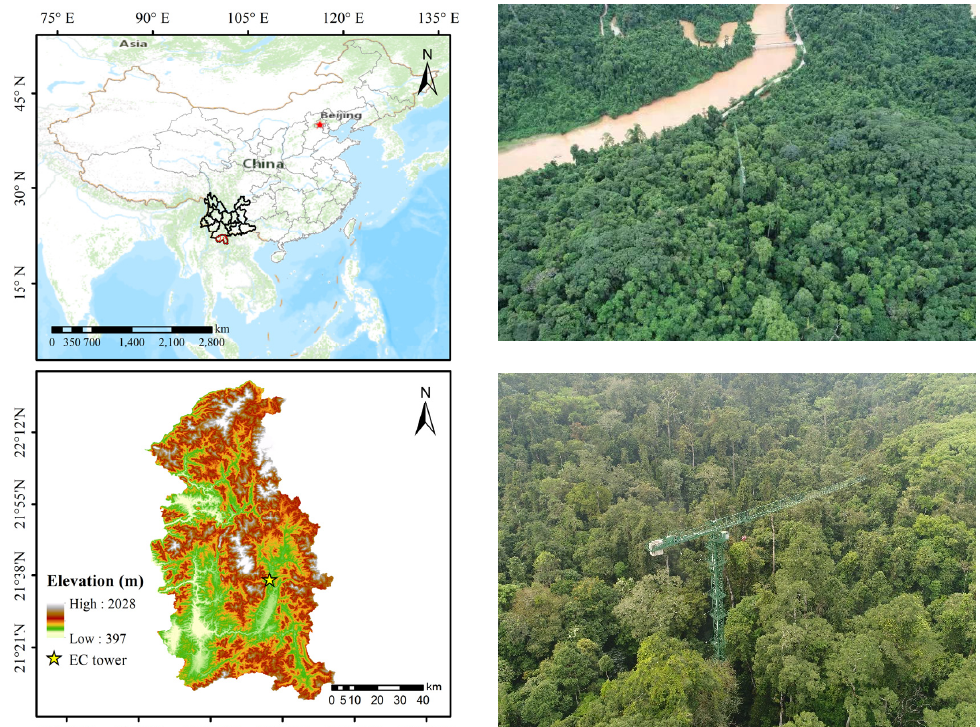
Figure 1. Geographical location and elevation information of the EC flux tower in Bubang Village, Mengla County, Xishuangbanna ( left ); images in study region ( right ).